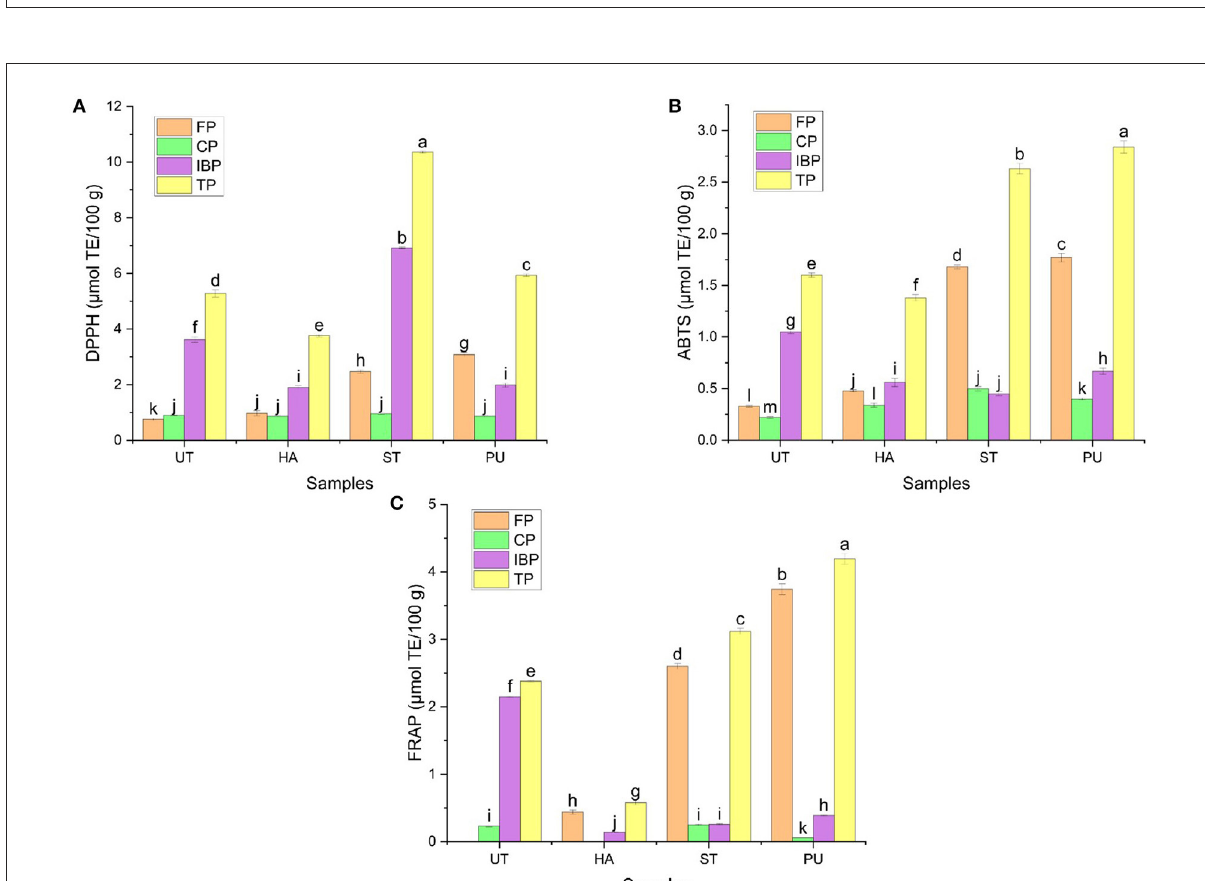
FIGURE12 The antioxidant capacities of FP, CP, and IBP of camellia oil from untreated and HA, ST, PU pretreated camellia seeds. [ (A) DPPH, (B) ABTS, (C) FRAP]. Bars with no letter in common are significant different ( P <